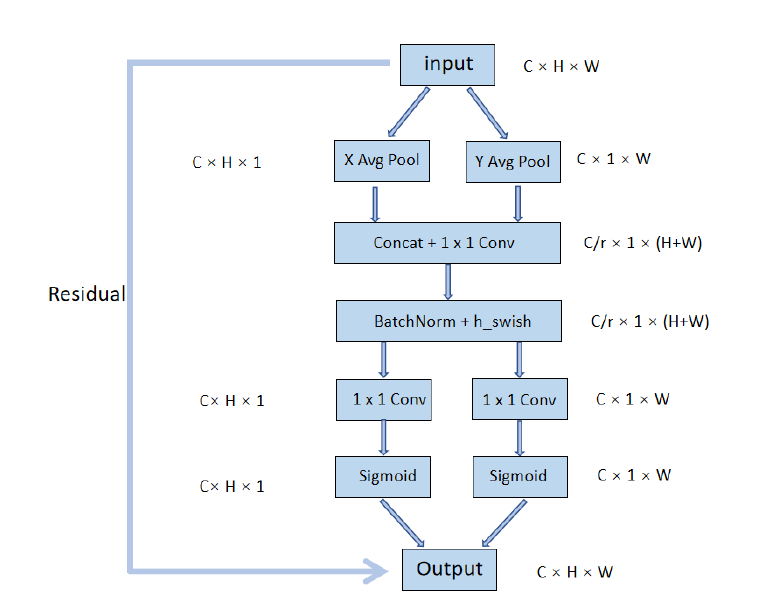
Figure 6. The structure of coordinate